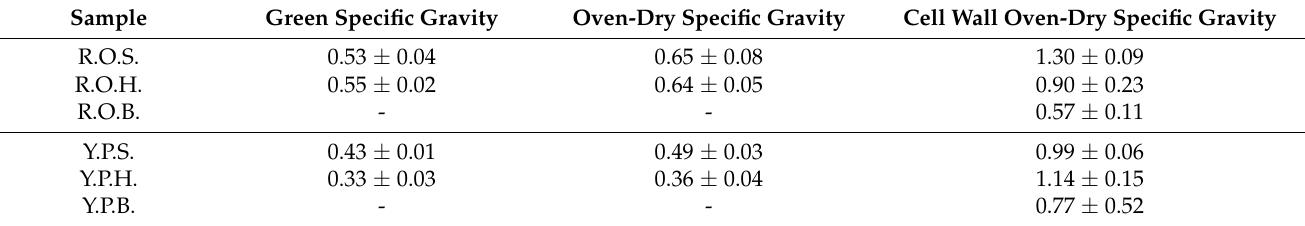
Table 2. Mean and standard deviation for specific gravities for sapwood and heartwood of red oak and yellow-poplar